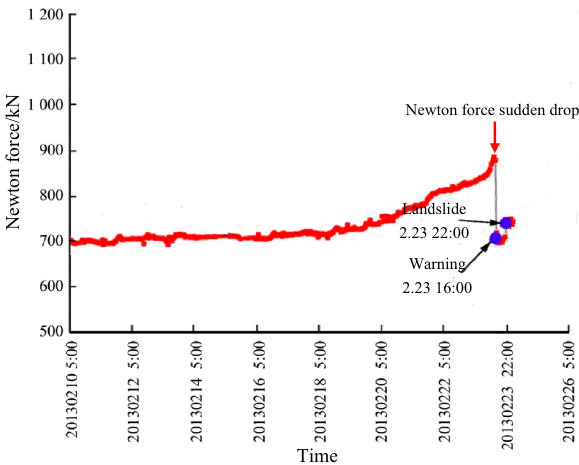
Figure 7. Monitoring warning curves of Newton force in Nanfen open pit